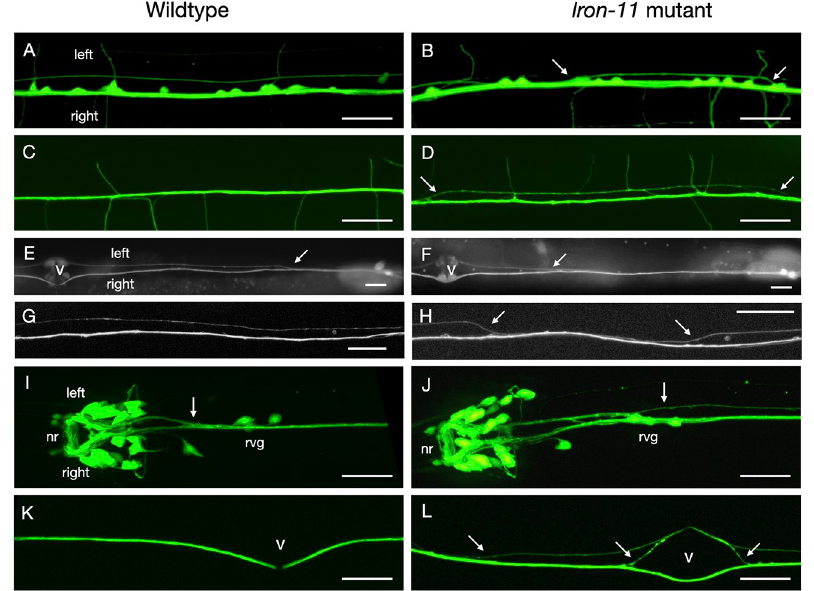
Fig 3. Pan-neuronal, pioneer and interneuron defects in lron-11 mutants. Panels A, C, E, G, I, K show wildtype, panels B, D, F, H, J, L show lron-11 mutants. The anterior side of the animals are towards the left of the image, the left side of the animals is towards the top of the image. Scale bars: 20 μ m. A, B: VNC visualized with the pan-neuronal marker evIs111[rgef-1 :: GFP] . A) In wildtype animals axons do not cross between left and right axon tracts. B) in lron- 11(ok2333) mutant animals axons cross between the left and right axon tracts (arrows). C, D: DNC visualized with the pan-neuronal marker evIs111[rgef-1 :: GFP] . C) In wildtype animals axons are tightly fasciculated. D) in lron-11(ok2333) mutant animals axons are partially defasciculated (arrows). E-H: Pioneer axons (PVPR and AVG) visualized with hdIs26[odr-2 :: CFP & sra-6 :: DsRed2] . PVPR is the fainter axon in the left tract. AVG is the brighter axon below it, in the right tract. E) In wildtype animals PVPR crosses from the right tract into the left tract close to the posterior end of the VNC (arrow). F) In lron-11(ok2333) mutant animals the PVPR axons sometimes crosses into the left tract at a much more anterior position (arrow, ‘late separation defect’) close to the vulva (marked with a ‘v’). G) In wildtype animals pioneer axons stay in their axon tracts. H) In lron-11(ok2333) the PVPR axon sometimes crosses into the right axon tract and then back into the left axon tract (arrows). I-L: Command interneuron axons visualized with rhIs4[glr-1 :: GFP] . I) In wildtype animals CI axons entering the VNC from the nerve ring (nr) on the left side cross into the right axon tract anterior to the retrovescicular ganglion (rvg). J) In lron-11 ( ok2333 ) mutant animals, some CI axons are late crossing into the right tract (arrow). K) In wildtype animals all CI axons extend in the right axon tract (‘v’ marks the position of the vulva). L) In lron-11 ( ok2333 ) mutant animals, some CI axons cross into the left tract at various positions and sometime cross back